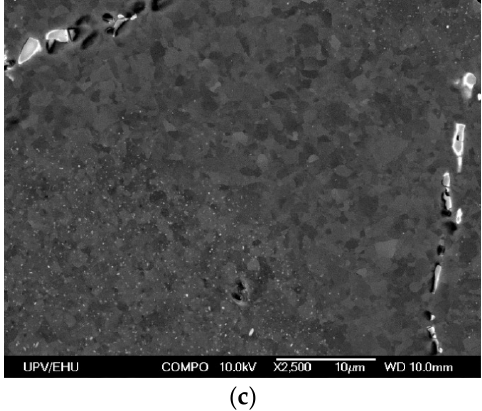
Figure 9. SEM (Scanning Electron Microscopy) micrographs of different AA3103 states forged at 250 °C: ( a ) AA3103 at N0; ( b ) AA3103 at N2; ( c ) AA3103 at N4.